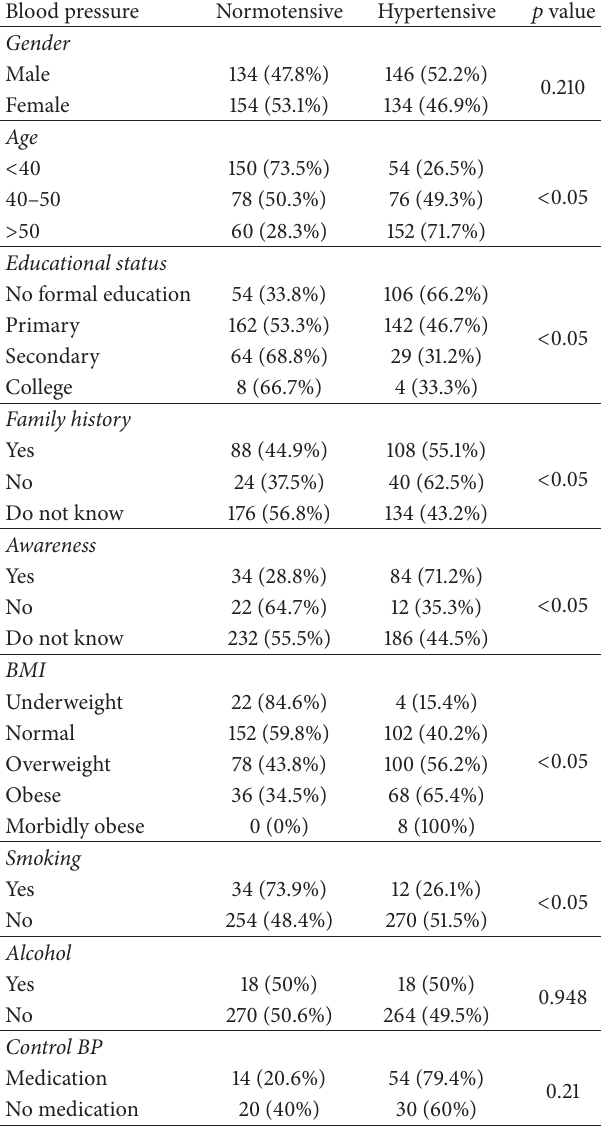
Table 1: Prevalence, risk factors, awareness, and control of blood